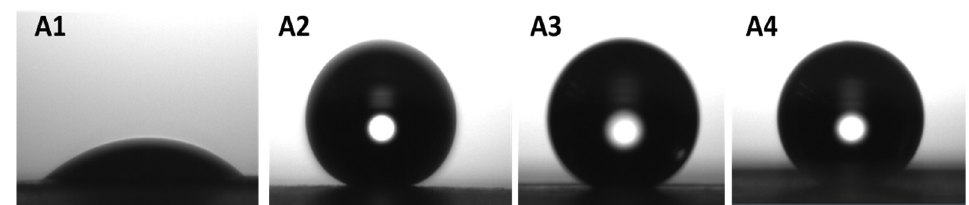
Figure 7. Shape of the water droplets after 30 s on: ( A1 ): Paper, ( A2 ): Paper/PLA/SiO2 annealed at 160 °C for 20 s, ( A3 ): Paper/PCL/SiO 2 annealed at 55 °C for 20 s, ( A4 ): Paper/PHBV/SiO 2 annealed at 120 °C for 20 s.